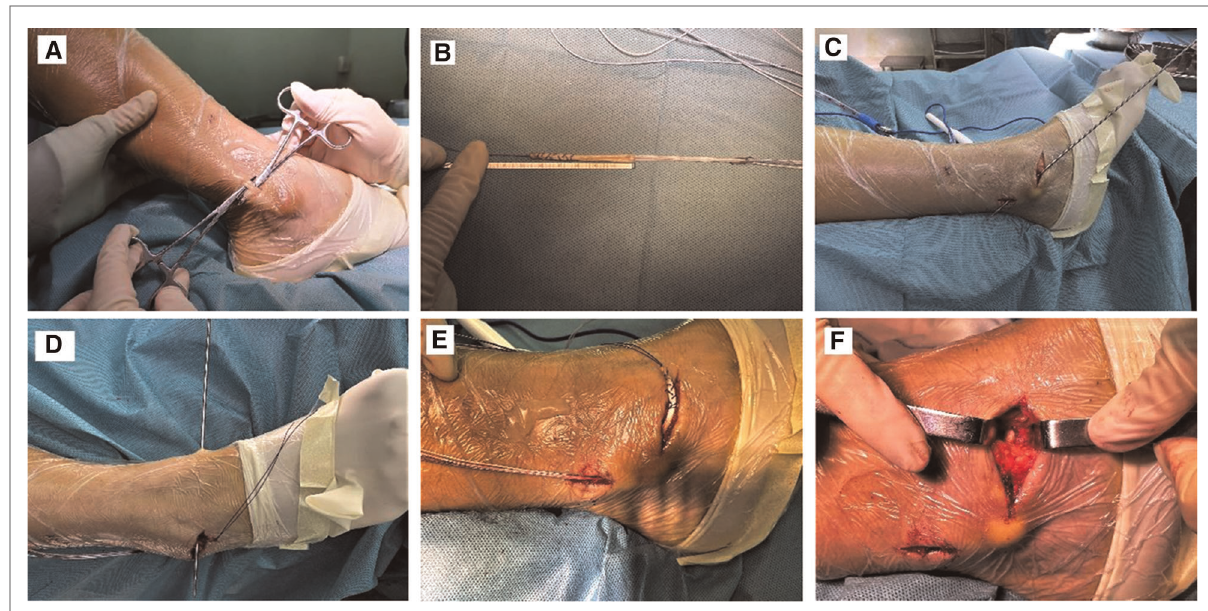
FIGURE 1 The surgical procedure of anatomical reconstruction of the anterior talo fi bular ligament with autologous half-bundle peroneal longus tendon. ( A,B ) The autologous half-bundle peroneal longus tendon preparation. ( C ) Fibular tunnel preparation. ( D ) Talus tunnel preparation. ( E,F ) The autologous half-bundle peroneal longus tendon implantation.